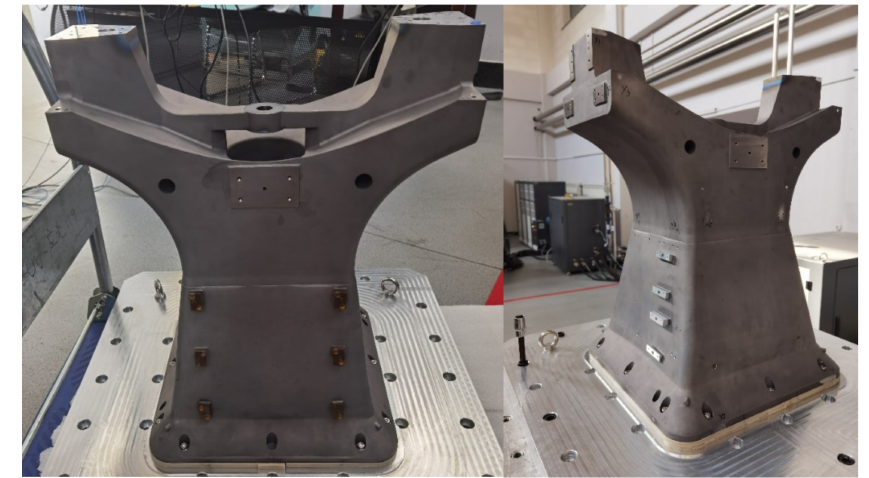
Figure 8. The printed model of the vertical bracket manufactured by